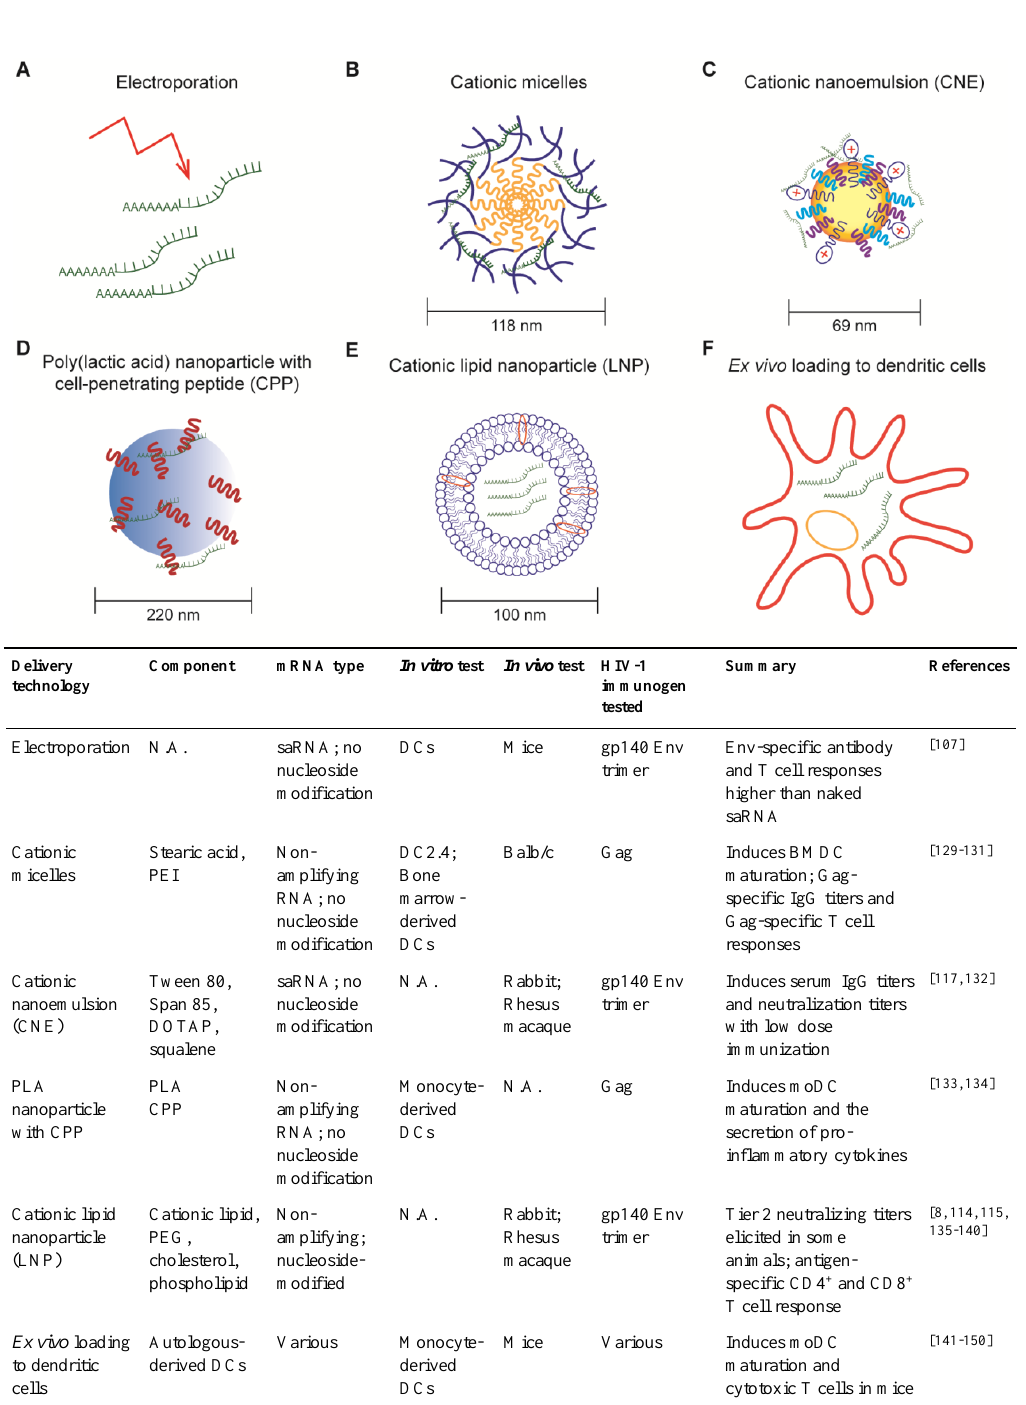
Figure 2. Delivery methods for HIV mRNA vaccine. ( A ) Electroporation; ( B ) Cationic micelles composed of stearic acid (yellow) and Polyethylenimine (PEI) (blue); ( C ) Cationic nanoemulsion (CNE); The yellow core shows squalene. Surfactant such as Tween 80 and Span 85 are shown in blue and purple. Cationic lipid DOTAP (Dioleoyl-3-trimethylammonium propane) is shown with red ‘+’ mark; ( D ) poly(lactic acid) (PLA) nanoparticle (blue core) with cell penetrating peptide (CPP) (shown in red); ( E ) Cationic lipid nanoparticle (LNP); figure shows a lipid bilayer with other components that can be included, such as Polyethylene glycol (PEG), cholesterol or phospholipid; ( F ) Ex vivo loading of dendritic cell (DC). The table below summarizes the HIV mRNA vaccines that have been tested, detailing the delivery method, the type of mRNA, the in vitro and in vivo system used for testing, the mRNA-encoded immunogen and a short note on the